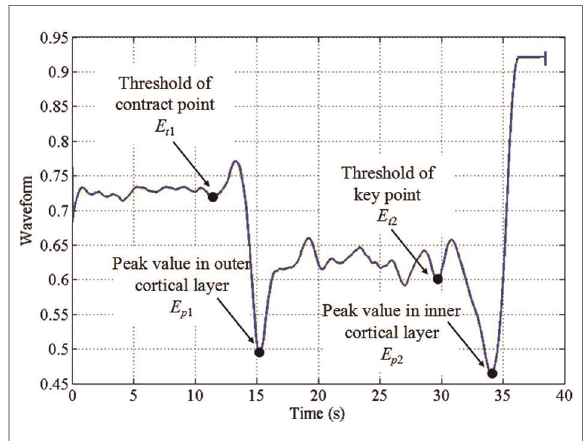
FIGURE 3 The exponential mean amplitude based state recognition from audio signal during robotic bone drilling (53).